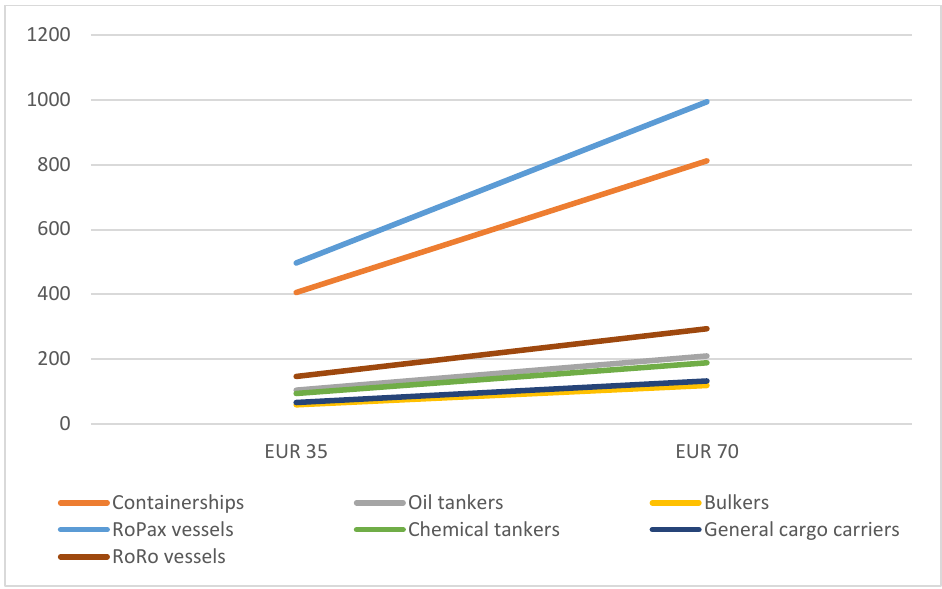
Figure 4. Cost increase per maritime segment assuming the inclusion of all internal EU voyages and 50% of incoming and outgoing voyages from/to an EU port, expressed in MEUR. Source : Created by the authors.